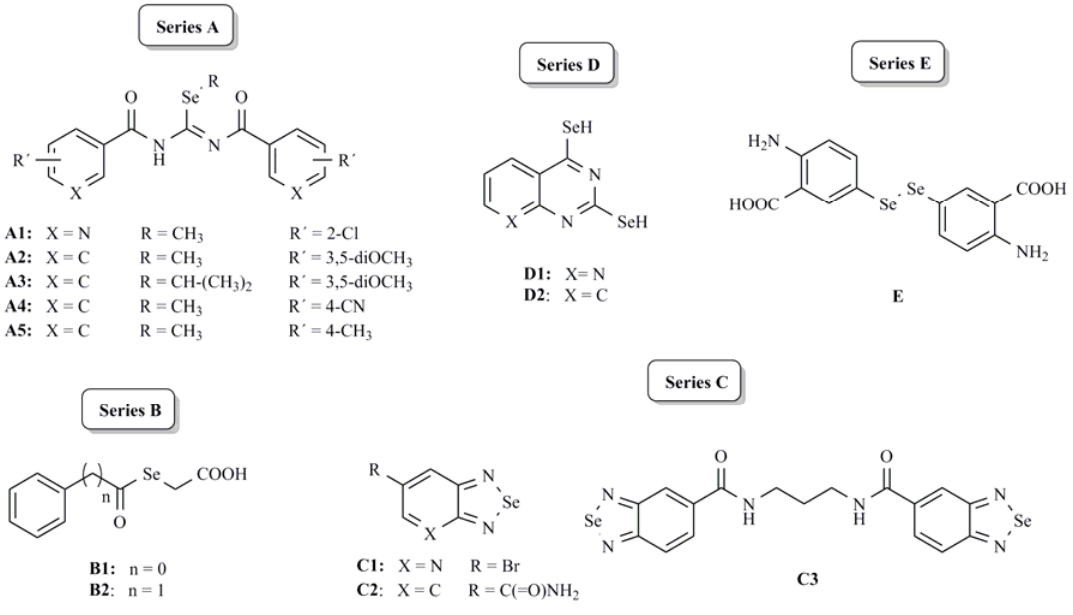
Figure 3. General structures for studied